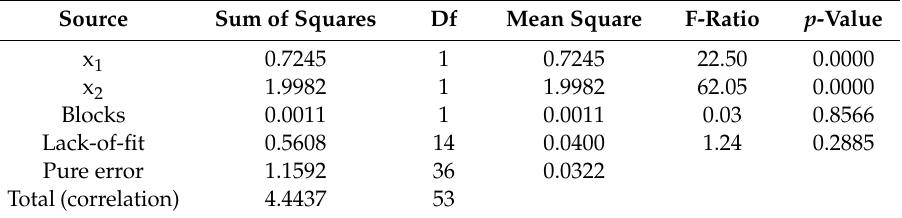
Table 4. Analysis of variance: the empirical model for predicting isoamyl